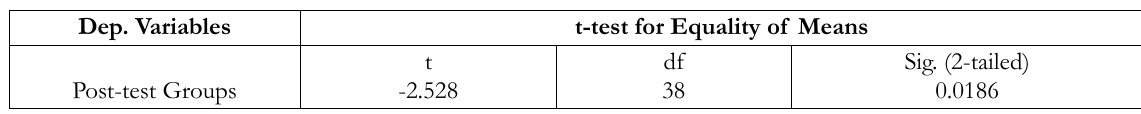
Table 4. Independent Sample T-Test Analysis of the Post-test Scores of the Experimental and Control Groups